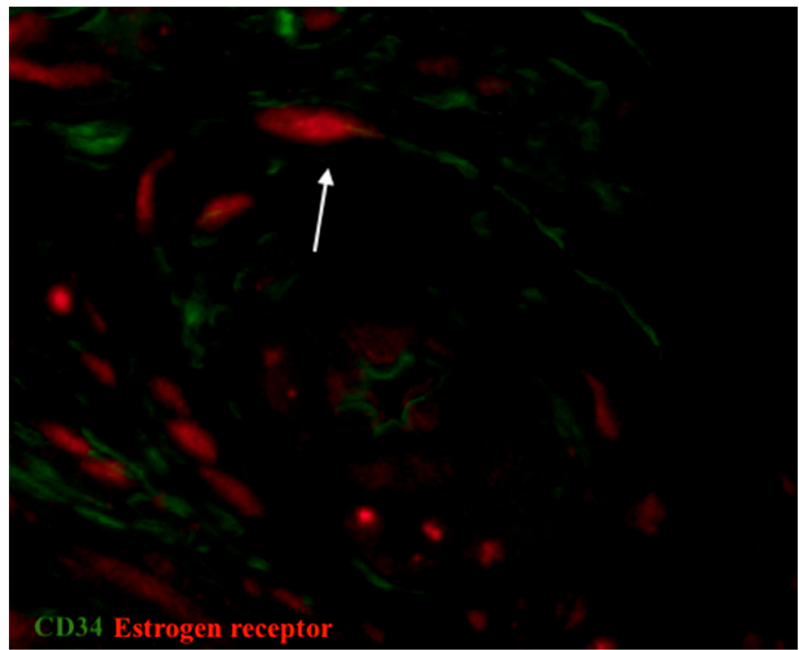
Figure 8. Sample of human oviduct stained for estrogen receptor (red, Alexa Fluor 594) and CD 34 (green, Alexa Fluor 488). A doubly immunopositive telocyte (with red nucleus and green cellular body and prolongations) was identified in the vicinity of a blood vessel in the muscular layer (shown by arrow). Total magnification: × 600.